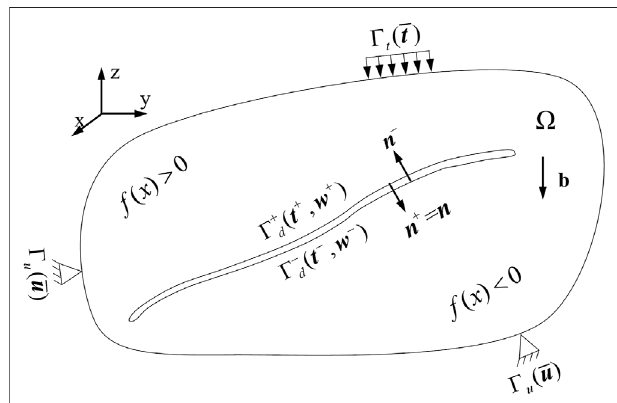
FIGURE 1 | Diagram of boundary value problem with